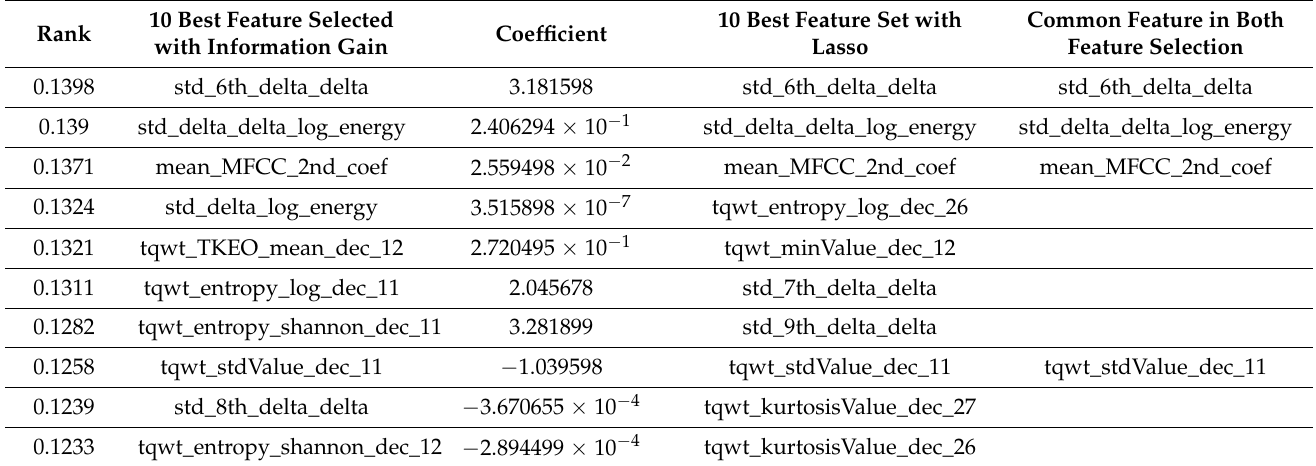
Table 10. The 10 subsets of features using information gain and lasso with rank and coefficient. 10 Best Feature Set